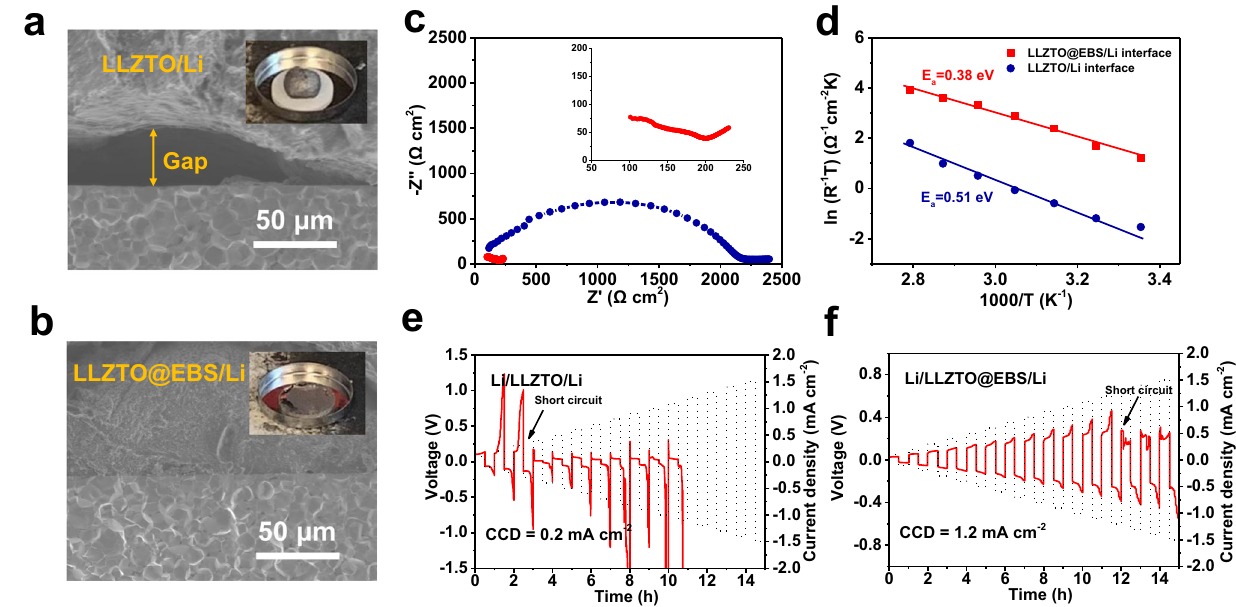
Fig. 3 Comparation of interfacial wetting behaviors between bare LLZTO and PAA-modi fi ed LLZTO with molten Li. SEM images of a the LLZTO/Li interface and b the LLZTO@EBS/Li interface. Insets are the corresponding digital images showing the wetting behaviors of molten Li on bare LLZTO or LLZTO@EBS. c EIS spectra, d temperature-dependent interfacial resistance of the Li/LLZTO/Li and the Li/LLZTO@EBS/Li cells. e CCD of the Li/LLZTO/Li cell. f CCD of the Li/LLZTO@EBS/Li